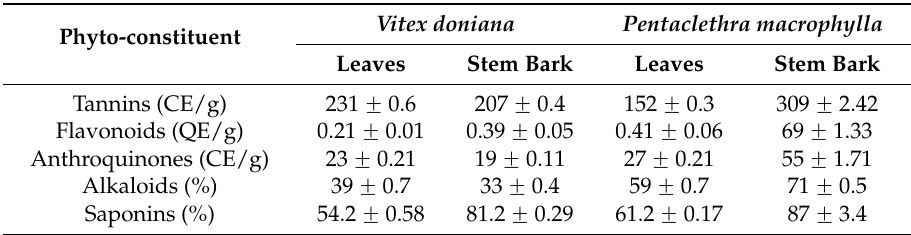
Table 1. Quantitation of the phytochemical composition of ethanol extracts of Vitex doniana and Pentaclethra macrophylla . Vitex doniana Pentaclethra macrophylla Phyto-constituent Leaves Stem Bark Leaves Stem Bark Tannins (CE/g) 231 ˘